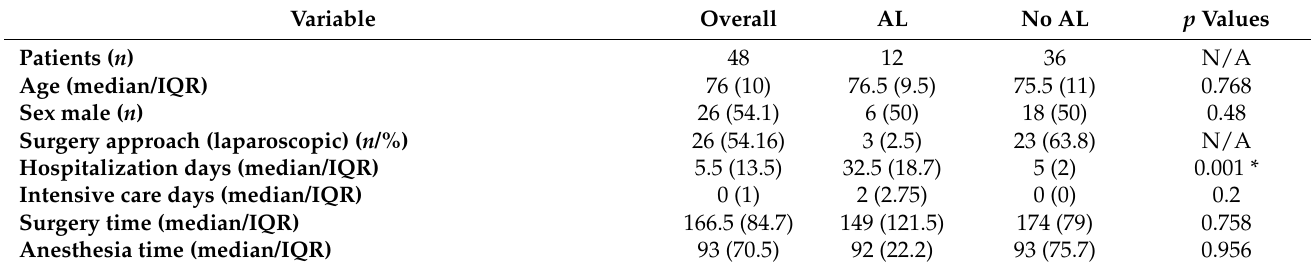
Table 2. Descriptive statistics of the